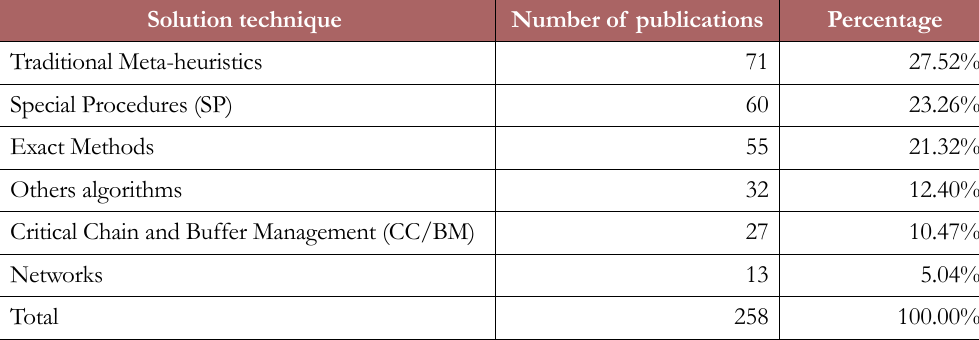
Table 2. Solution techniques applied by researchers